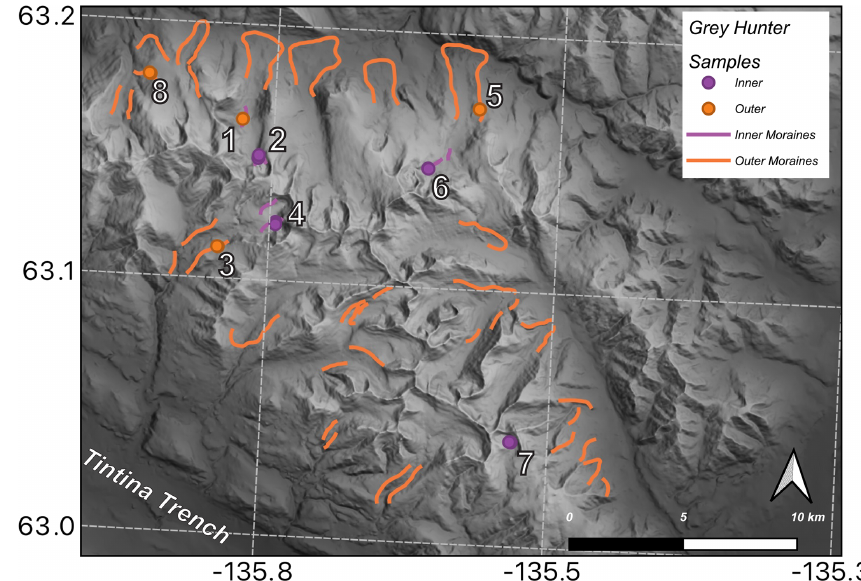
Figure 2. Shaded relief map of the Grey Hunter massif region. Outer moraines (orange) and inner moraines (purple) are shown. Sample locations are also shown for reference and labeled according to sample set ID. Samples comprising each same set are summarized in Table 1.